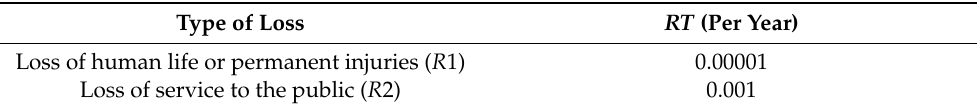
Table 2. Tolerable Risk